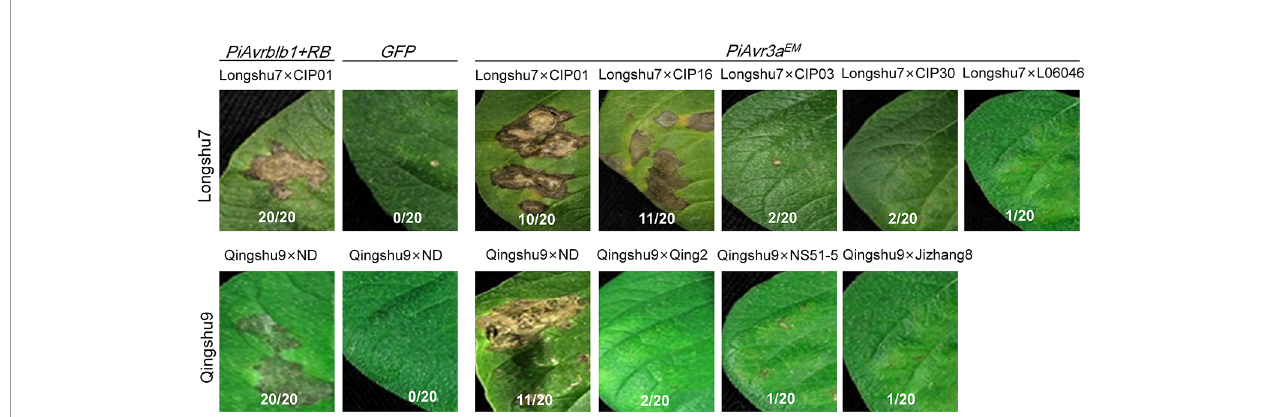
FIGURE 5 | Segregation of HR induced by recognition of P. infestans PiAvr3a EM in F1 populations using Longshu7 or Qingshu9 as a parental. Progenies derived from crosses Longshu7 X CIP01 and Longshu7 X CIP16 showed typical HR as that in Longshu7, and progenies from cross Qingshu9 X ND showed typical HR as that in Qingshu9. GFP was used as negative control and co-expression of PiAvrblb1 and RB was used as a positive control. The number of HR-responsive progenies/total number of progenies, were indicated in each crosses, with each progenies examined with 30 in fi ltration sites. All pictures were taken at 5 – 7